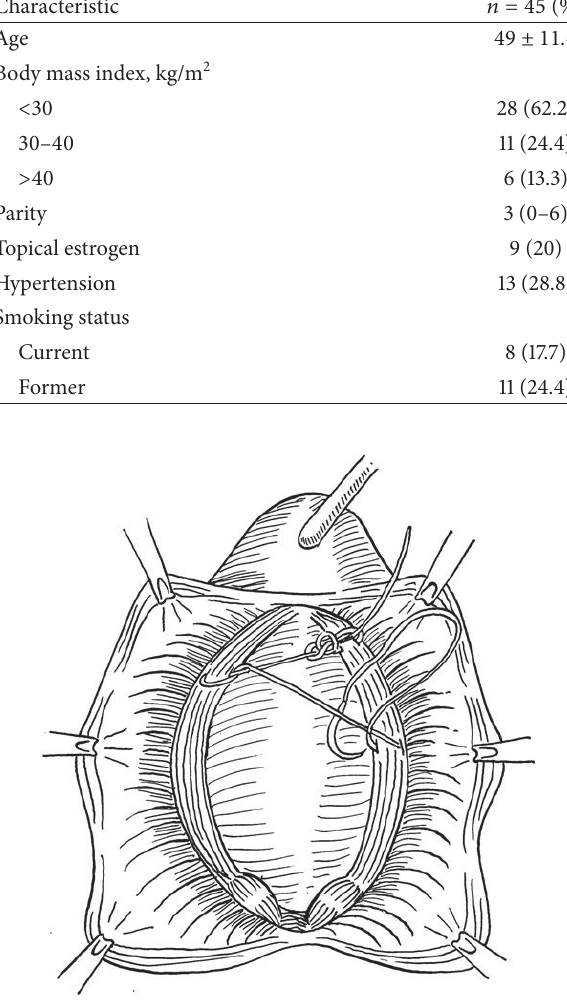
Figure 1: Slightly approximating continuous locking 2/0 polypropy- lene suture was placed inside the arcus tendineus fascia